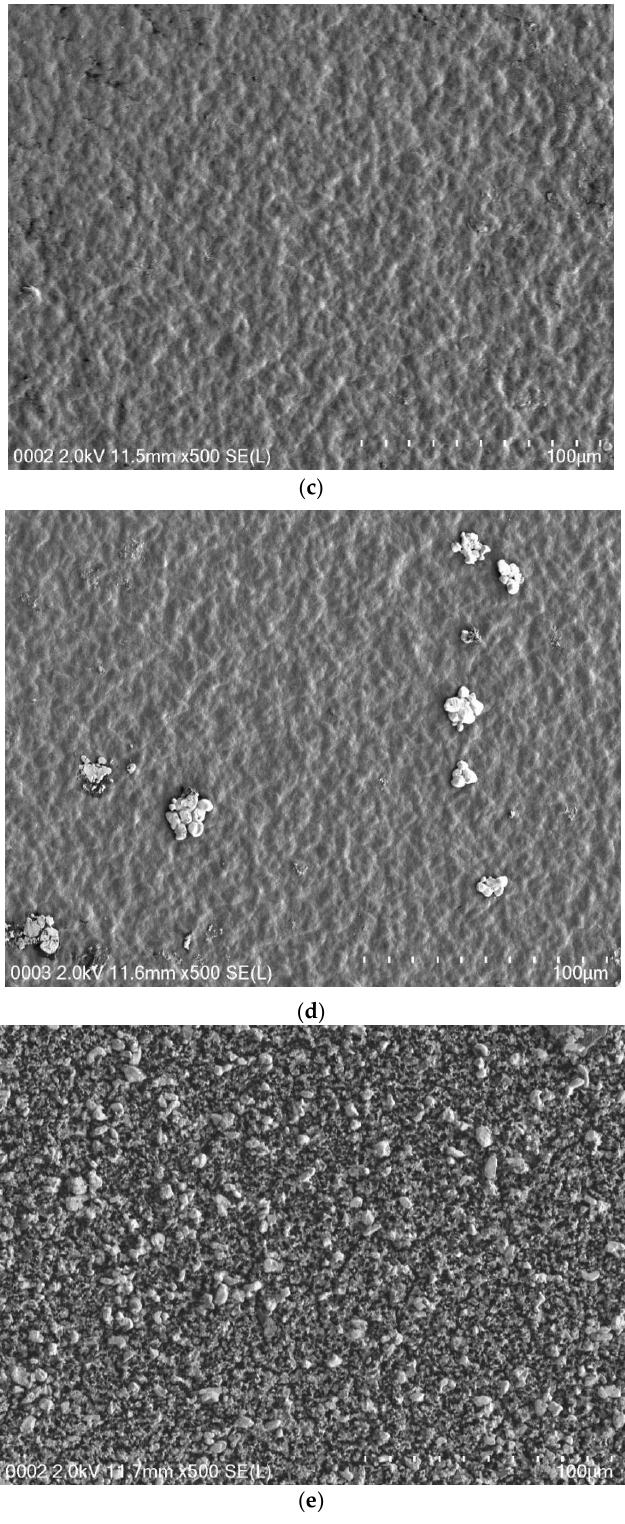
Figure 4. FESEM images for ( a ) PVCS 1, ( b ) PVCS 2, ( c ) PVCS 3, ( d ) PVCS 4 and ( e ) PVCS 5.